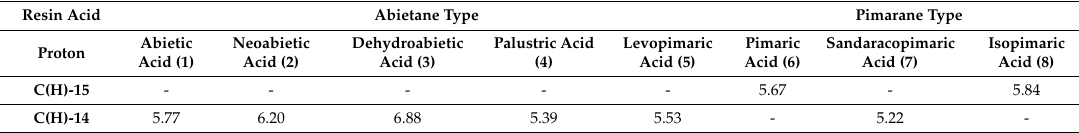
Table 1. 1 H-NMR proton’s chemical shifts of the studied resin acids selected for quantitation (400 MHz, CDCl 3 , δ -values in ppm).